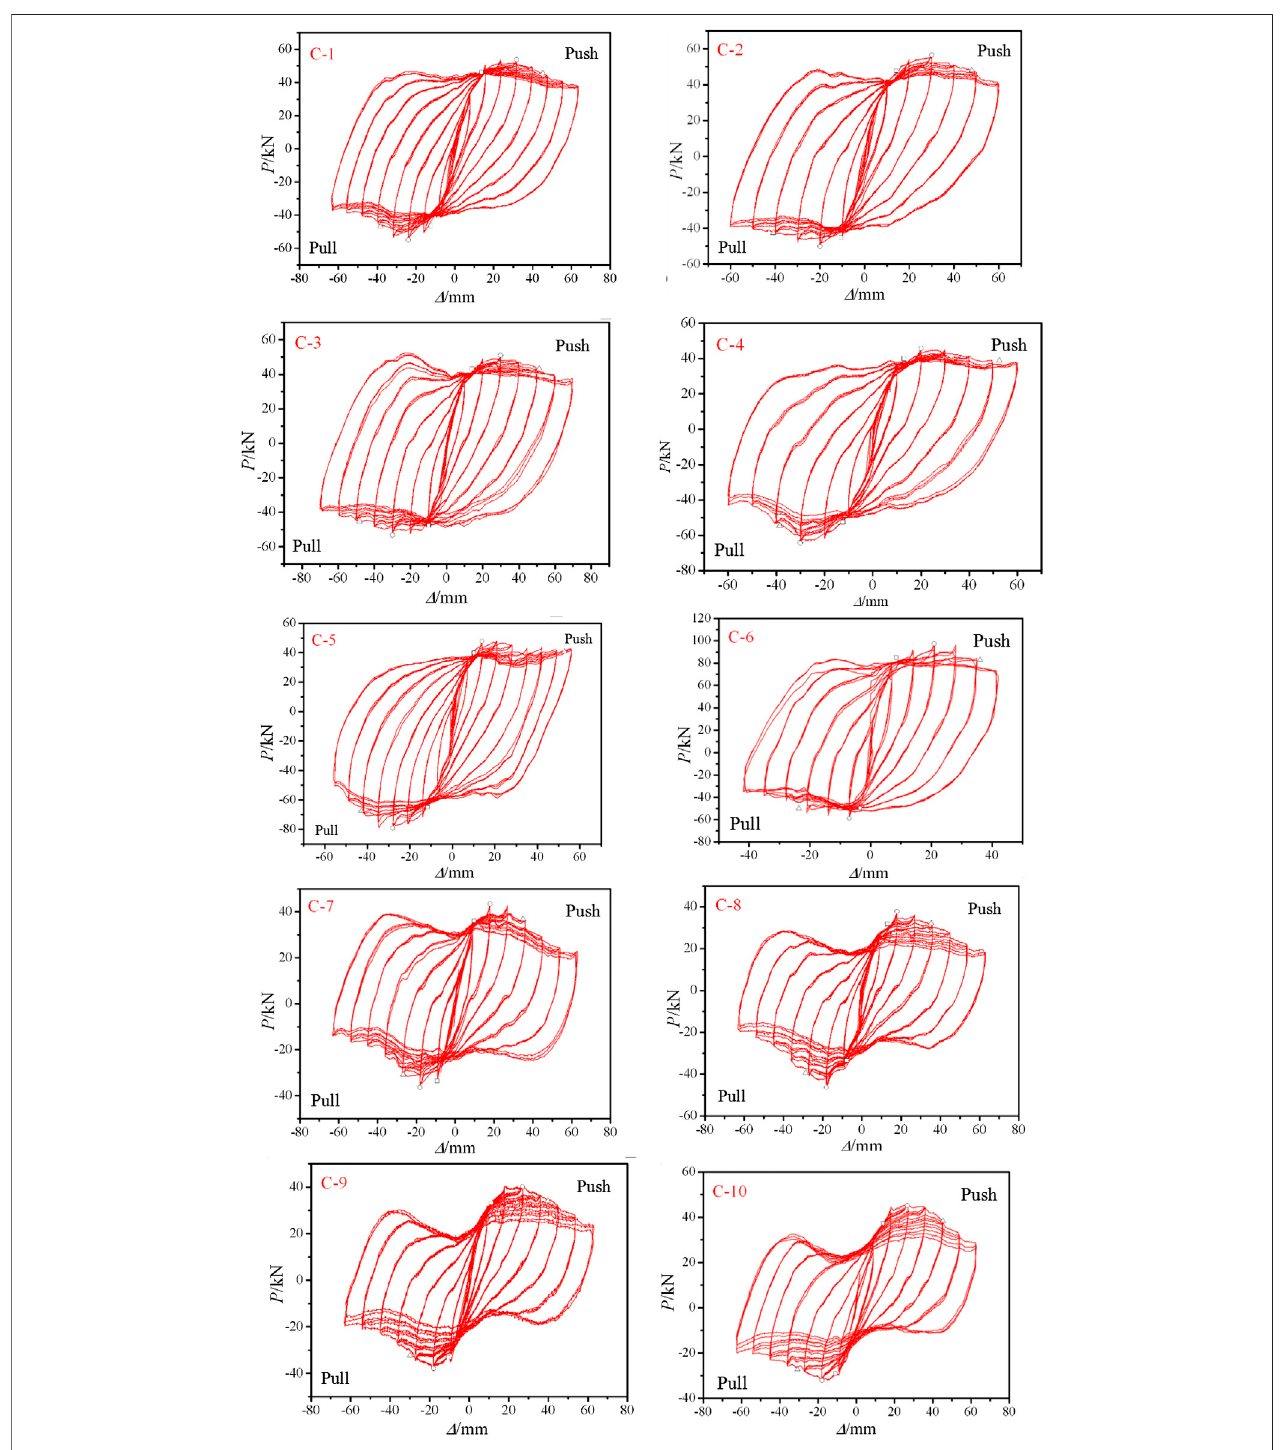
FIGURE 6 | Hysteresis curves of RCFST